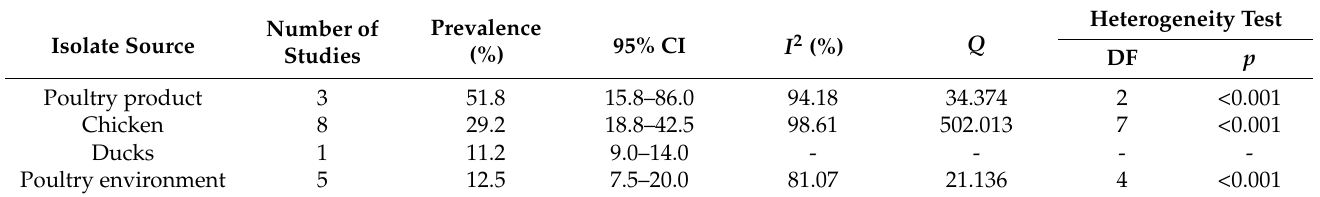
Table 4. Subgroup analysis for comparison of VRE in poultry in Malaysia across isolate sources.